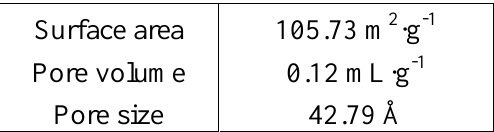
Table 1. Sulfated zirconia textural